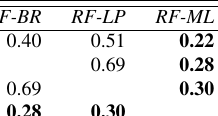
Table 3: Percentage of ties regarding classifiers built from features selected by IG-LP , RF-BR , RF-LP and RF-ML F-measure